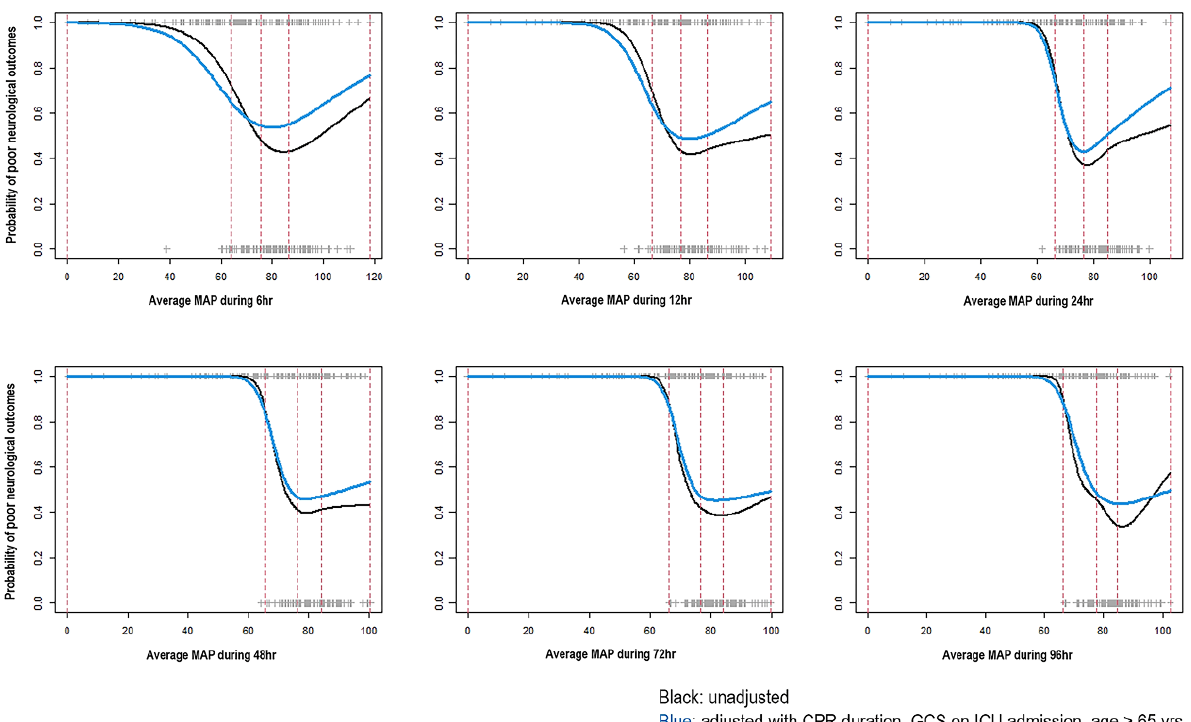
Figure 3. Spline curves of average mean arterial pressure (MAP) and poor neurologic outcomes according to the observation time. CPR, cardiopulmonary resuscitation; GCS, Glasgow Coma Scale; ICU, intensive care unit.